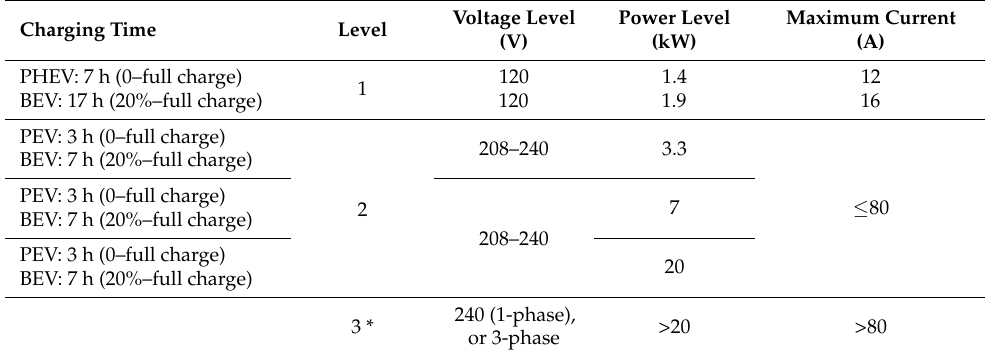
Table 2. Characteristics of AC level chargers.